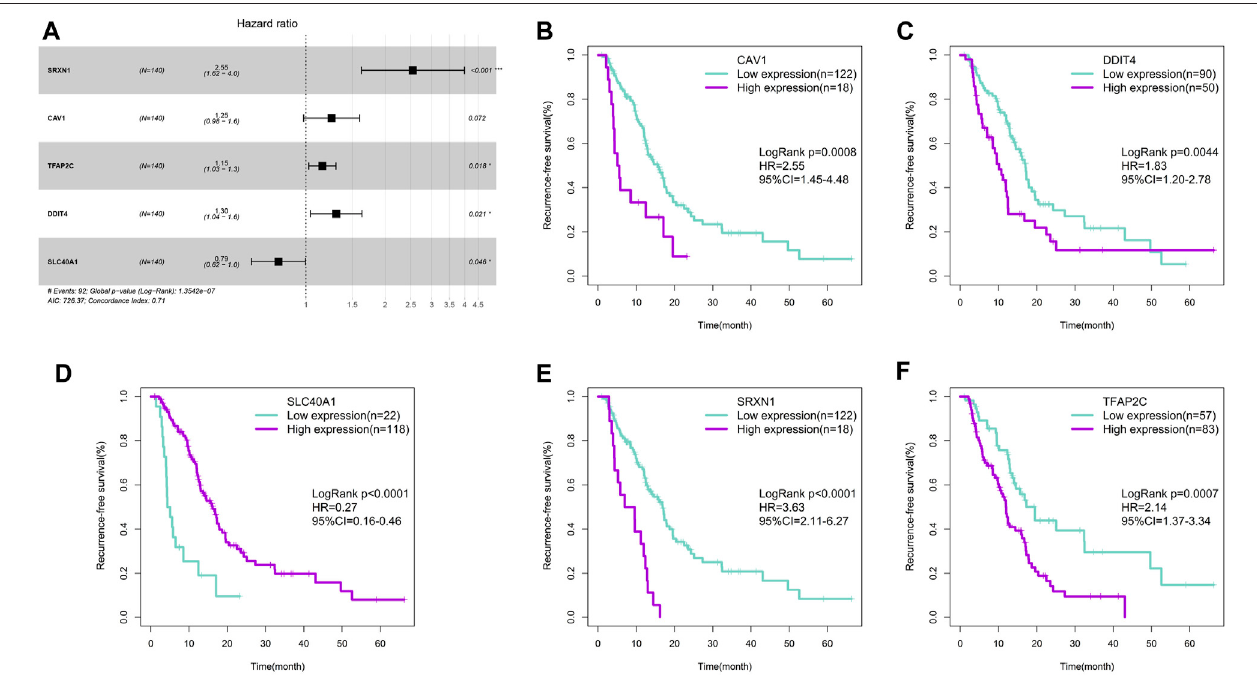
FIGURE1| Construction oftheferroptosis-relatedgenesignature. (A) Forestplotofthe fi veferroptosis-relatedgenes. (B) SurvivalcureforCAV1. (C) Survivalcure for DDIT4. (D) Survival cure for SLC40A1. (E) Survival cure for SRXN1. (F) Survival cure for TFAP2C.